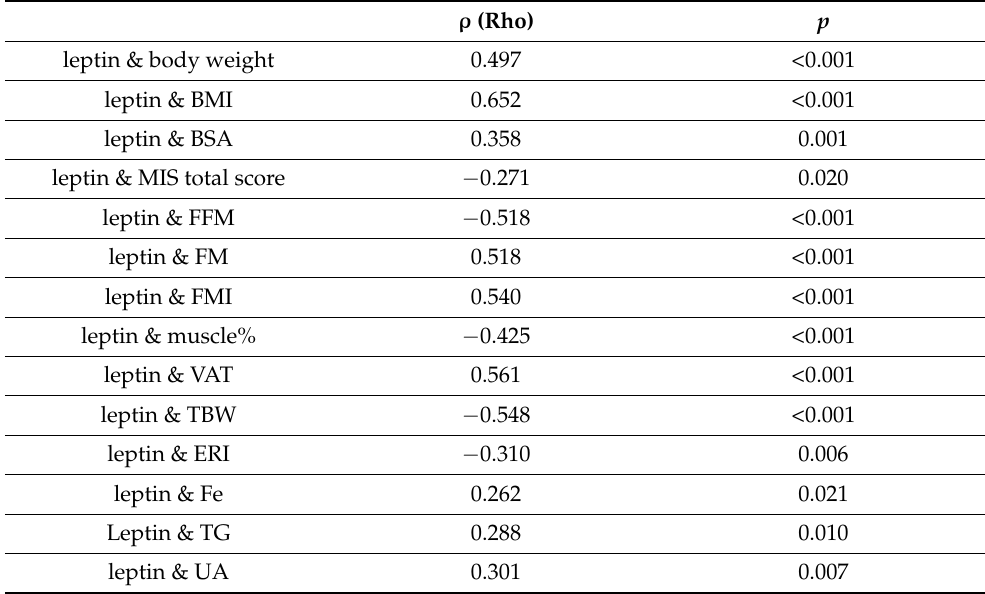
Table 2. Association of leptin levels, nutritional parameters and biochemical data; n = 78.